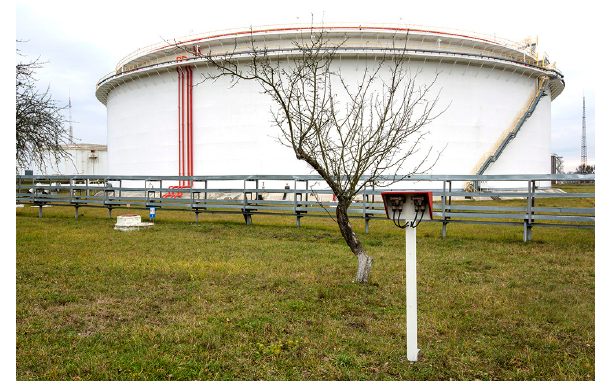
Figure 2. Ground vertical cylindrical steel welded tank with a nominal capacity of 75.000 m 3 with a floating roof and a double wall of the LODS “Brody”